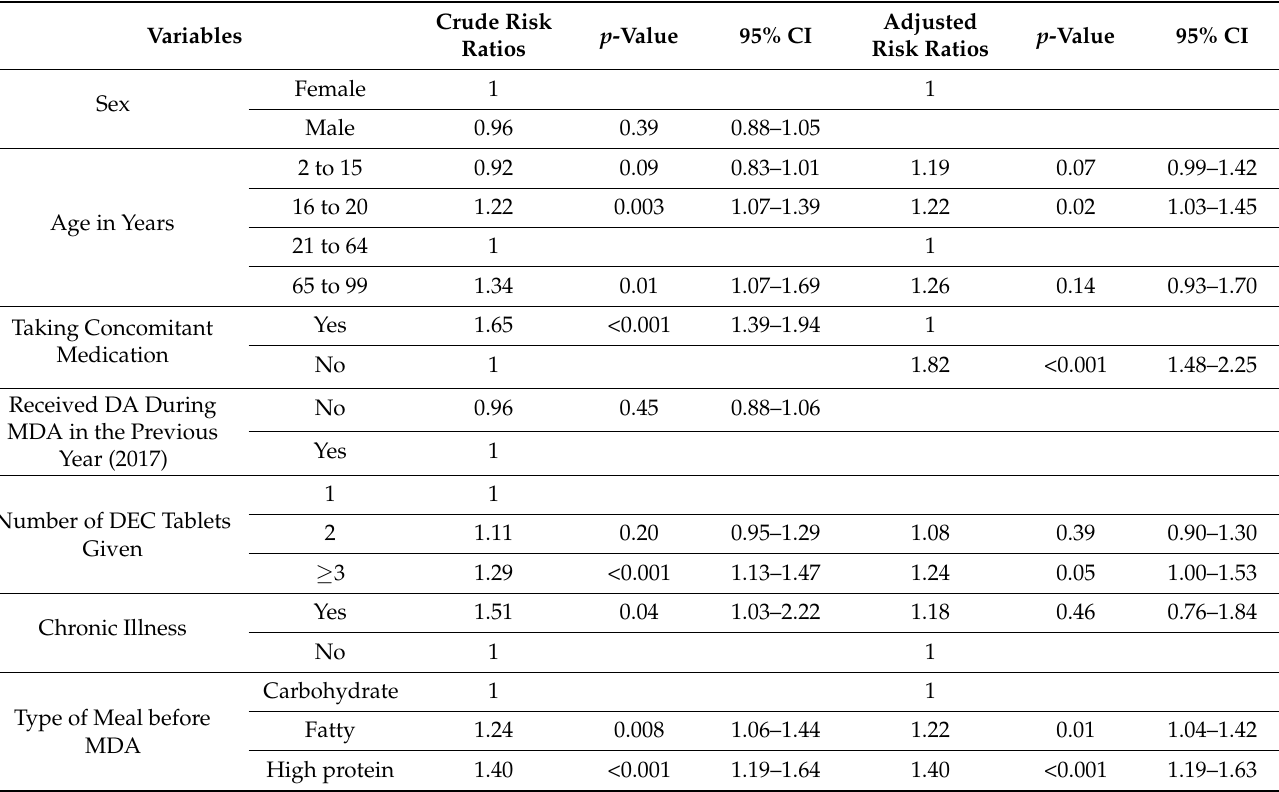
Table 4. Predictors of adverse events following mass diethylcarbamazine and albendazole administration for the elimination of lymphatic